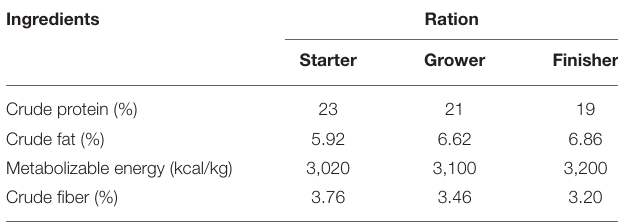
TABLE 1 | Chemical composition of the